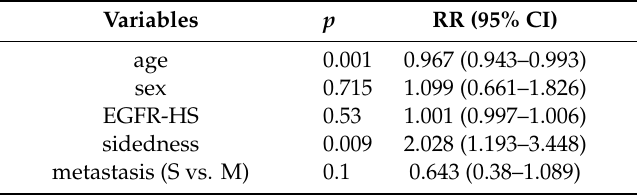
Table 2. Multivariant analysis of various prognostic / predictive factors of cetuximab e ffi cacy using Cox proportional hazard model of survival: EGFR protein expression of the primary tumors ( N = 88).